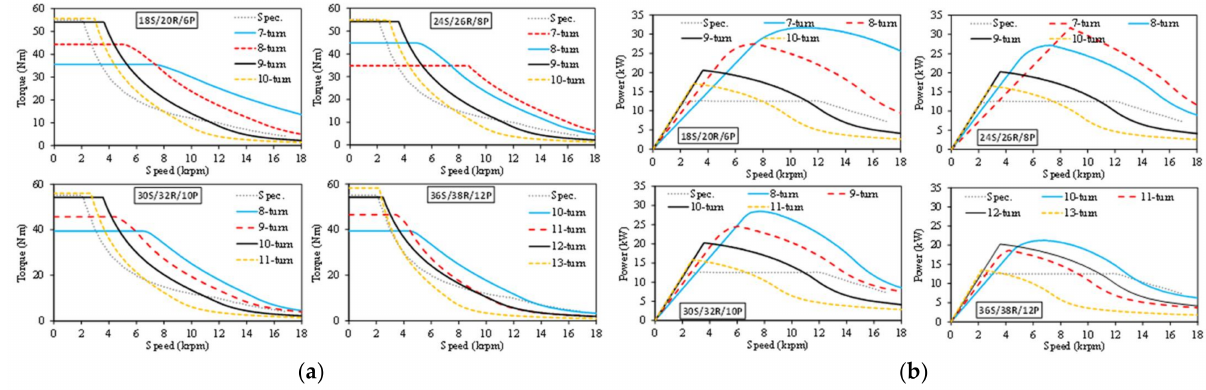
Figure 34. Flux-weakening characteristics of 90 mm AIMs with different S/P combinations and number of turns: ( a ) torque-speed and ( b )